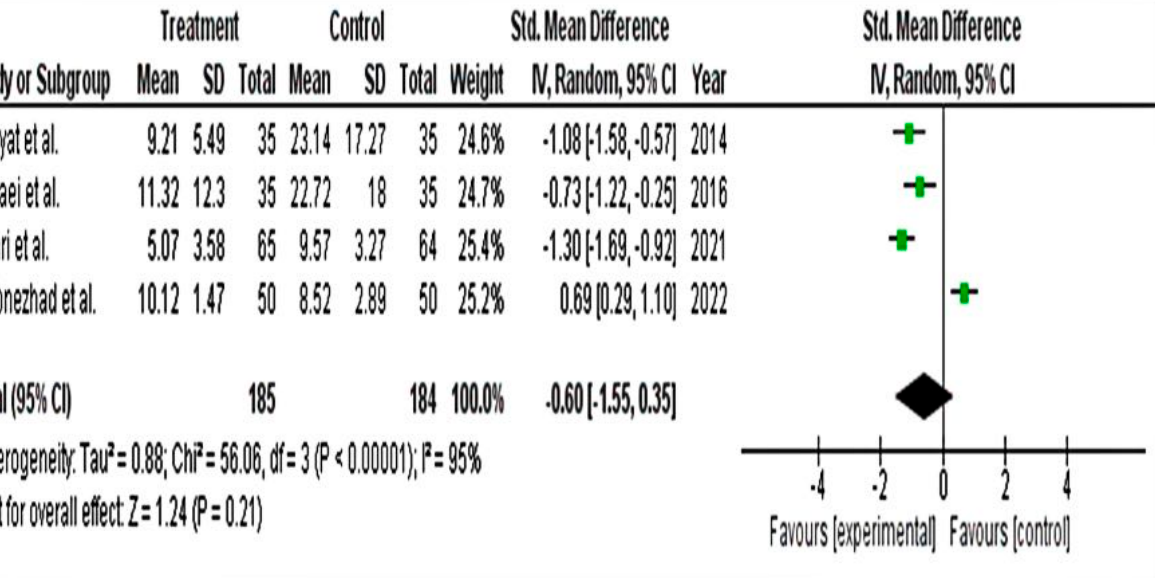
Figure 9. Forest plot for subgroup behavioural symptoms of PSST scale [1,5,49,51].